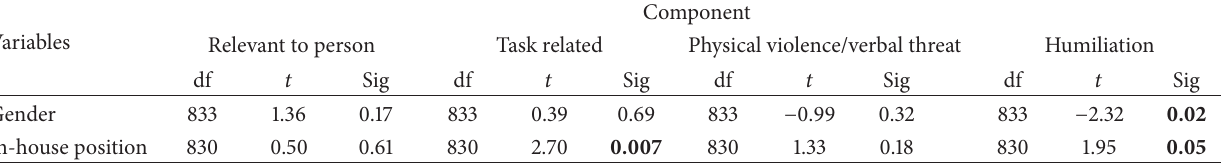
Table 2: 𝑡 -test results for